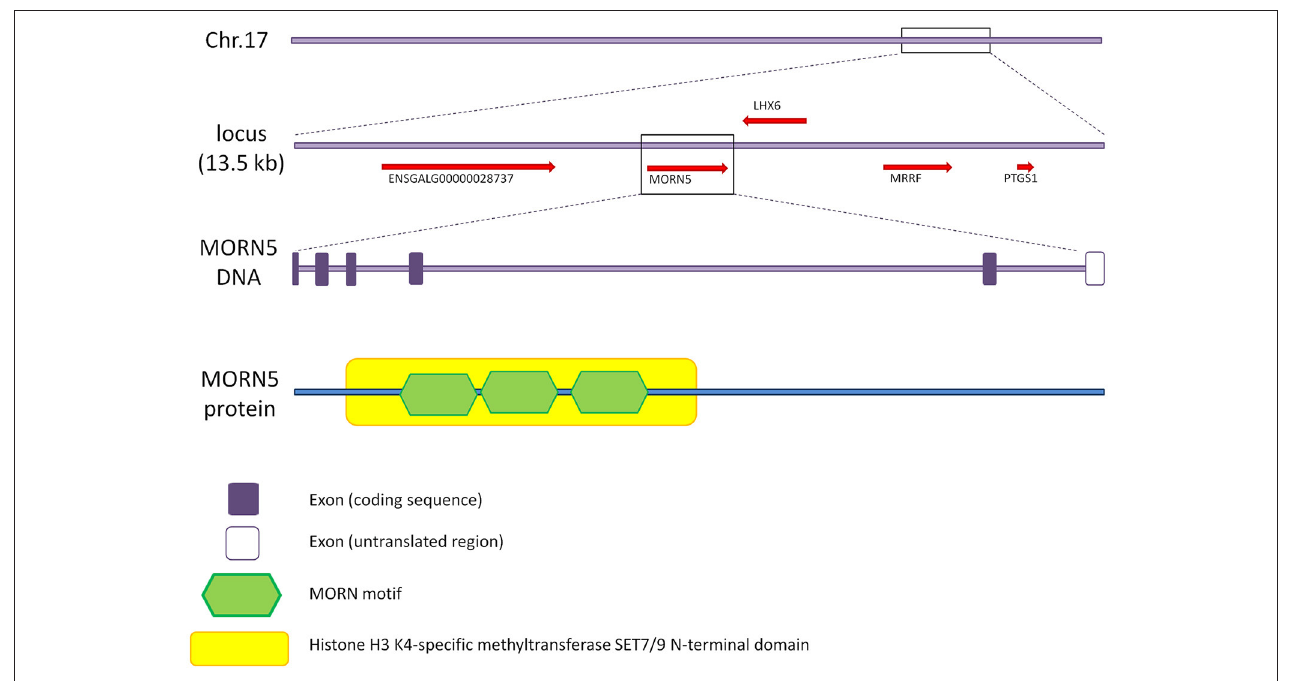
FIGURE 1 | Gene characteristics of chicken MORN5 and domain analysis. MORN5 gene is located on chromosome 17 of the chicken genome and its length is 13.5kb. The gene is composed of 6 exons where the last one is non-coding. The open reading frame codes for a protein 172 amino acids in length. The gene contains SSF82185 domain and three MORN